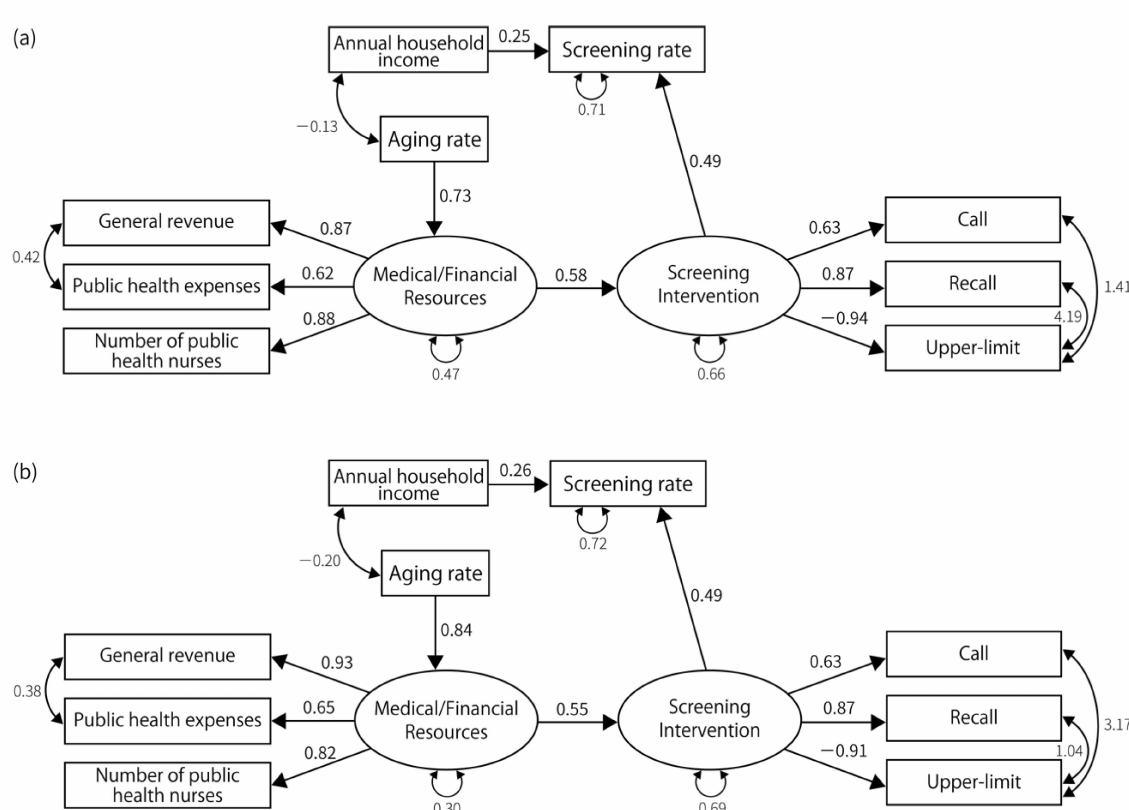
Figure 2. The final model for gastric cancer. ( a ) The final model for gastric cancer screening in males. GFI (goodness of fit index) = 0.872, AGFI (adjusted goodness of fit index) = 0.738, PGFI (parsimo- nious goodness of fit index) = 0.426, SRMR (standardized root mean square of residual) = 0.09, CFI (comparative fit index) = 0.96, RMSEA (root mean square error of approximation) = 0.080, p -value by χ 2 test = 0.155, χ 2 = 28.66, degrees of freedom = 22. ( b ) The final model for gastric cancer screening in females. GFI = 0.892, AGFI = 0.780, PGFI = 0.436, SRMR = 0.083, CFI = 0.96, RMSEA = 0.087, p -value by χ 2 test = 0.123, χ 2 = 29.82, degrees of freedom =